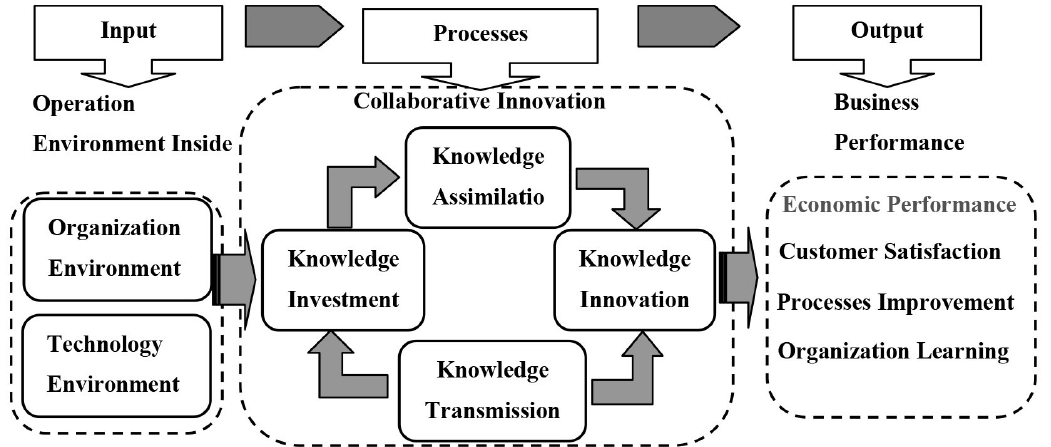
Figure 1. Processes of Inter-organizational Collaborative Innovation of Project-based Supply Chains Based on Knowledge